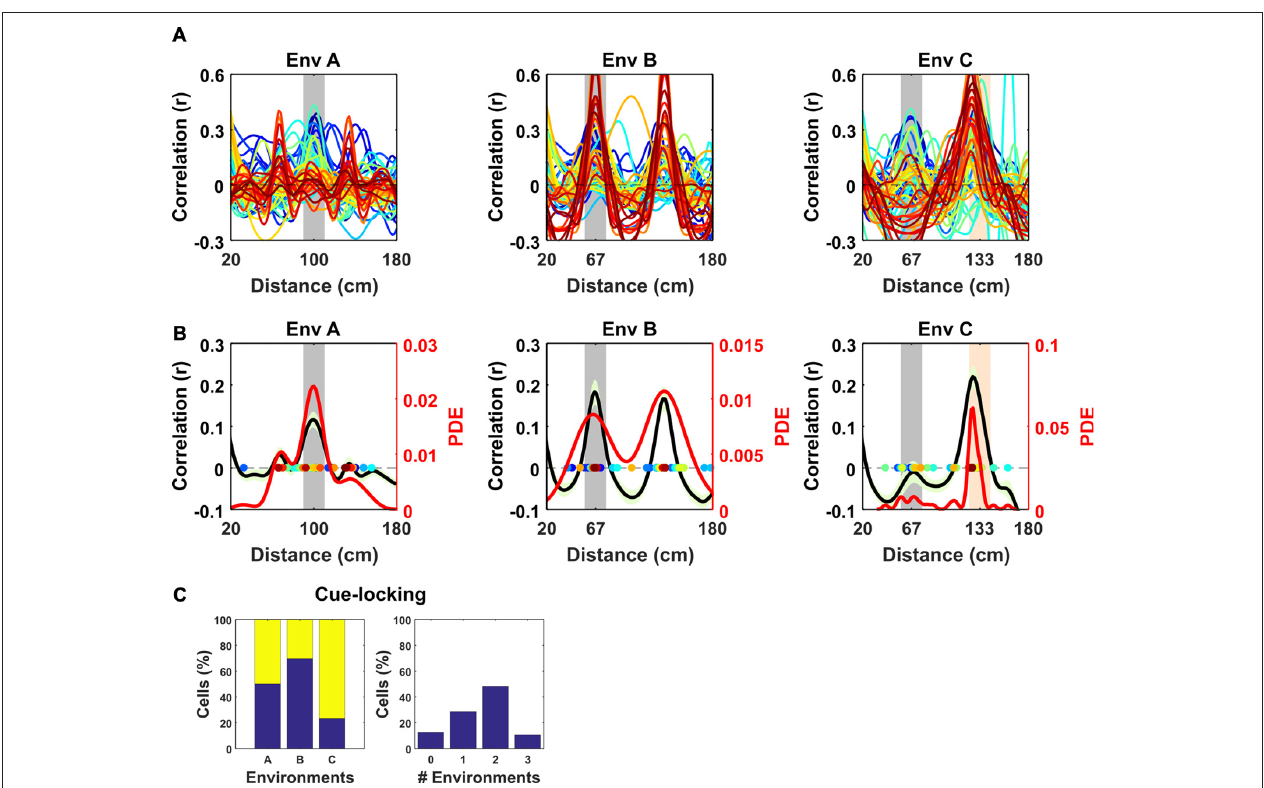
FIGURE 3 | Spatial frequency of the periodic non-grid cells. Within VR environments, periodic non-grid cells exhibited regular firing at the same spatial frequency as the underlying repetitive visual cues, unlike grid cells which showed weaker spatial periodicity of varying frequencies. (A) SAC of all non-grid periodic cells across VR environments. Note the clear peaks centered on the spatial frequency of the repeating cues of each environment (gray block for Environment A and B and gray and orange in Environment C). (B) Mean (black line) ± SEM (light green shaded area) of the SAC (left y -axis) across cells within each environment showing clear coincidence with the frequency of the repetitive cues (gray block). Colored dots indicate the dominant spatial frequency of each cell (color matches lines in A ) and were used to compute the kernel density estimate (red line, right y -axis). (C) Histograms showing ( left ) percentages of non-cue locked (blue) and cue-locked (yellow) periodic cells within each VR environment. Right , Histograms showing percentages of periodic cells exhibiting cue locking in multiple environments. Most cells (>85%) displayed cue-locking in at least one VR